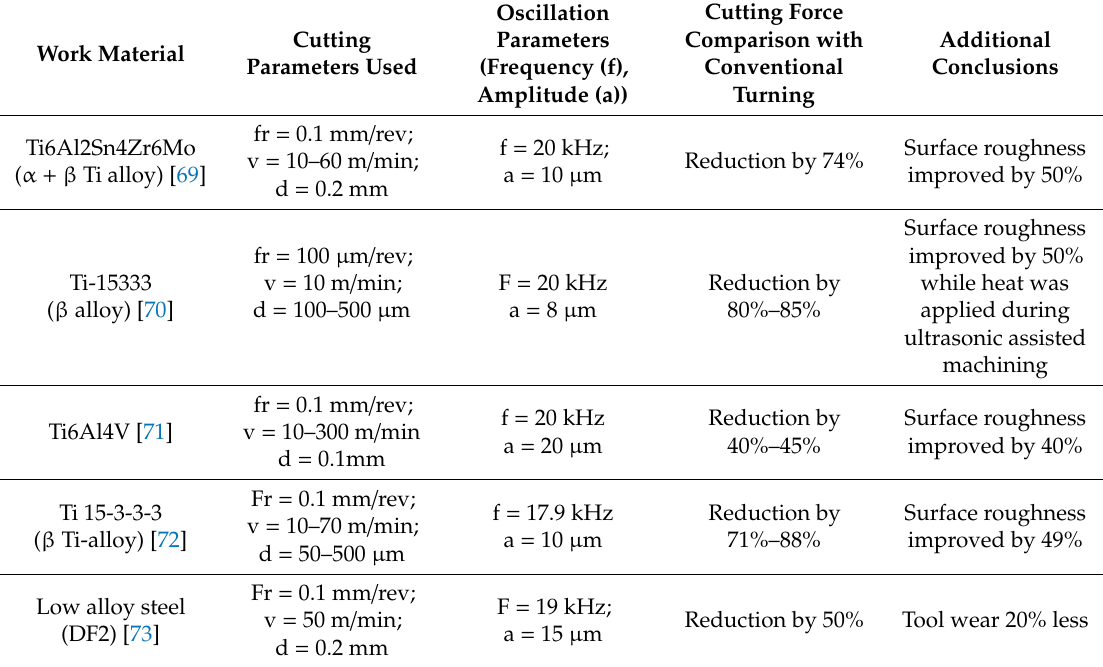
Table 1. Tabulated summary of recent e ff orts made in the vibration-assisted machining (VAM) of titanium alloys and